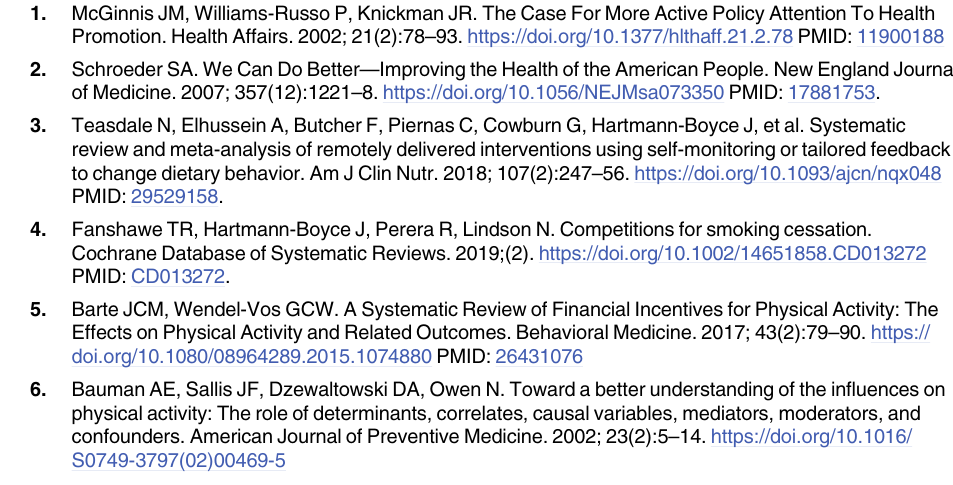
S1 Table. Variable weights by class. S2 Table. Fit statistics and number of individuals per class for latent class models for two to seven